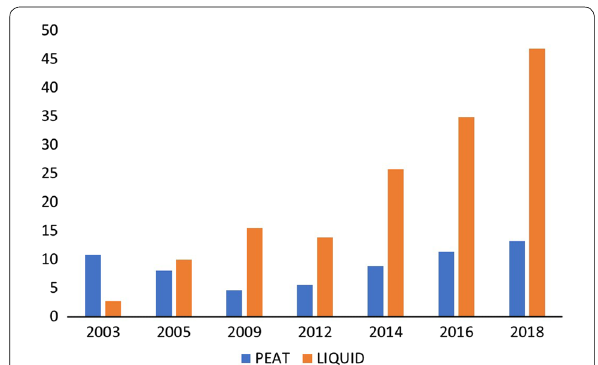
Fig. 1 Market of microbial inoculants in Brazil in the last 15 years (million